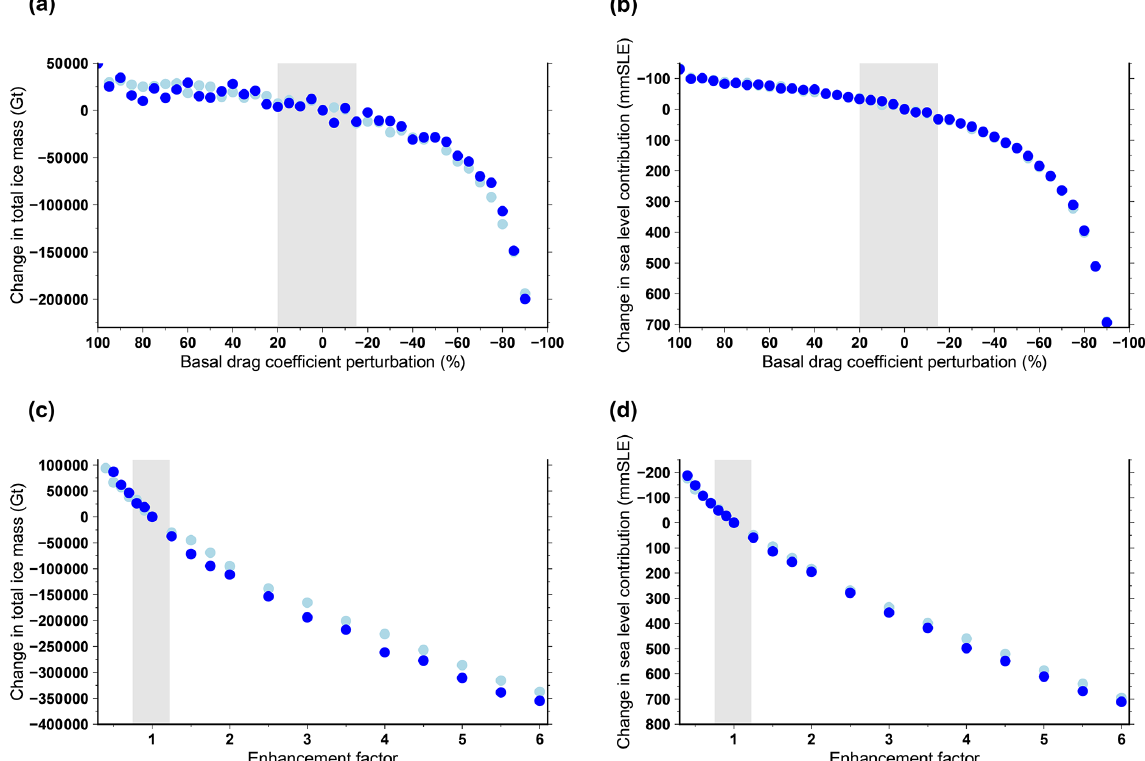
Figure 14. Change in ice volume for a modification of the basal-drag coefficient (a, b) and different values of the enhancement factor (c, d) . In this figure, each dot represents the difference in 2100 with respect to the standard experiment (no basal-drag-coefficient perturbation and enhancement factor at 1). The dark-blue dots are projection experiments that use NorESM1-M under RCP8.5 with a medium oceanic sensitivity. The light-blue dots are control experiments ctrl_proj . Some control experiments can be hidden by the projection experiments if they imply a similar volume change. The perturbations are applied starting in the year 2045. The vertical grey band stands for the range of perturbations that produce 0.15% of total mass change in the perturbed control experiment with respect to the standard control experiment. The difference is expressed in total ice mass (a, c) and ice volume contributing to sea level rise (b, d)